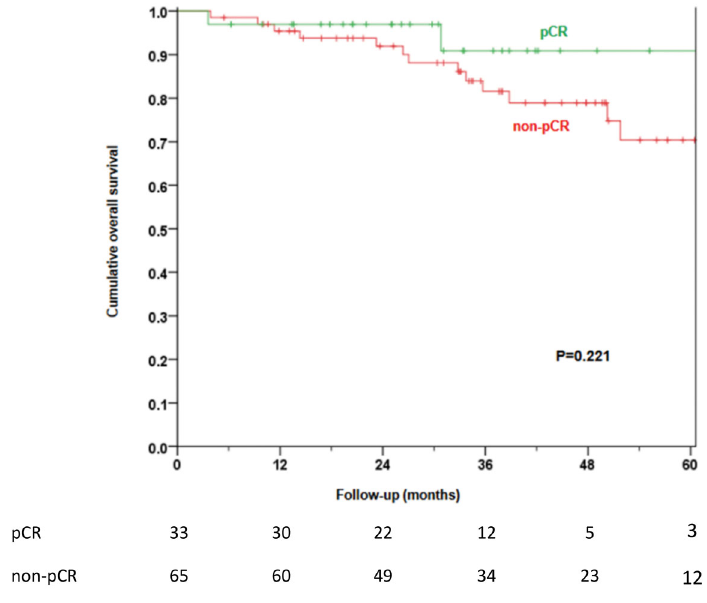
Figure 2. Estimated 5-year overall survival by pathologic complete response (pCR) (Kaplan-Meier method). The number of patients at risk at each follow-up time is shown below the DNA repair gene expression in pre-NACT biopsies Table 1 summarizes the expression of DNA repair genes in pre-NACT core biopsy fragments according to neoadjuvant response. The DNA expression of 2 genes